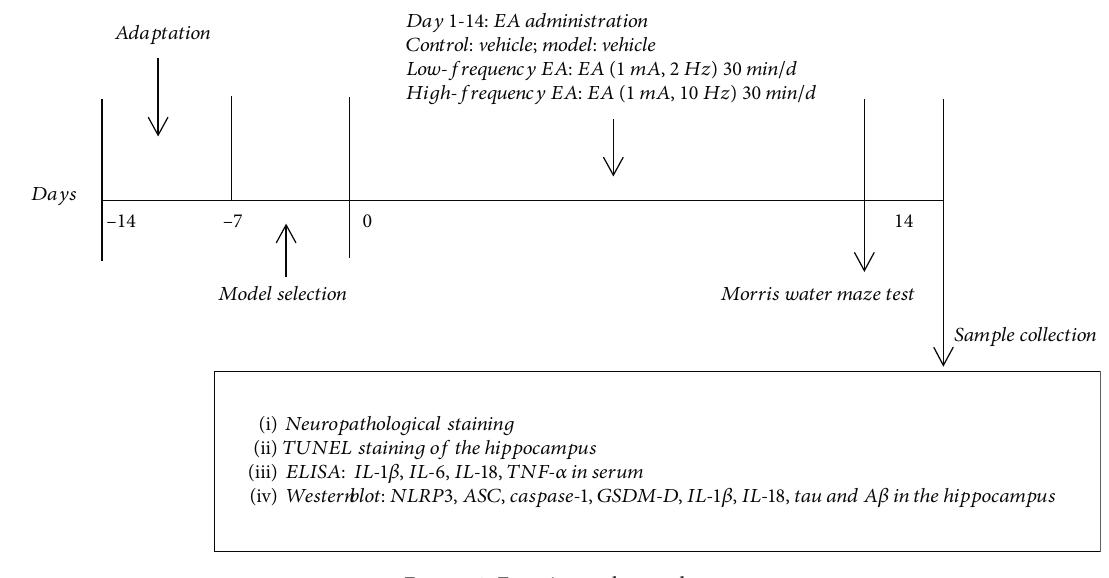
Figure 1: Experimental